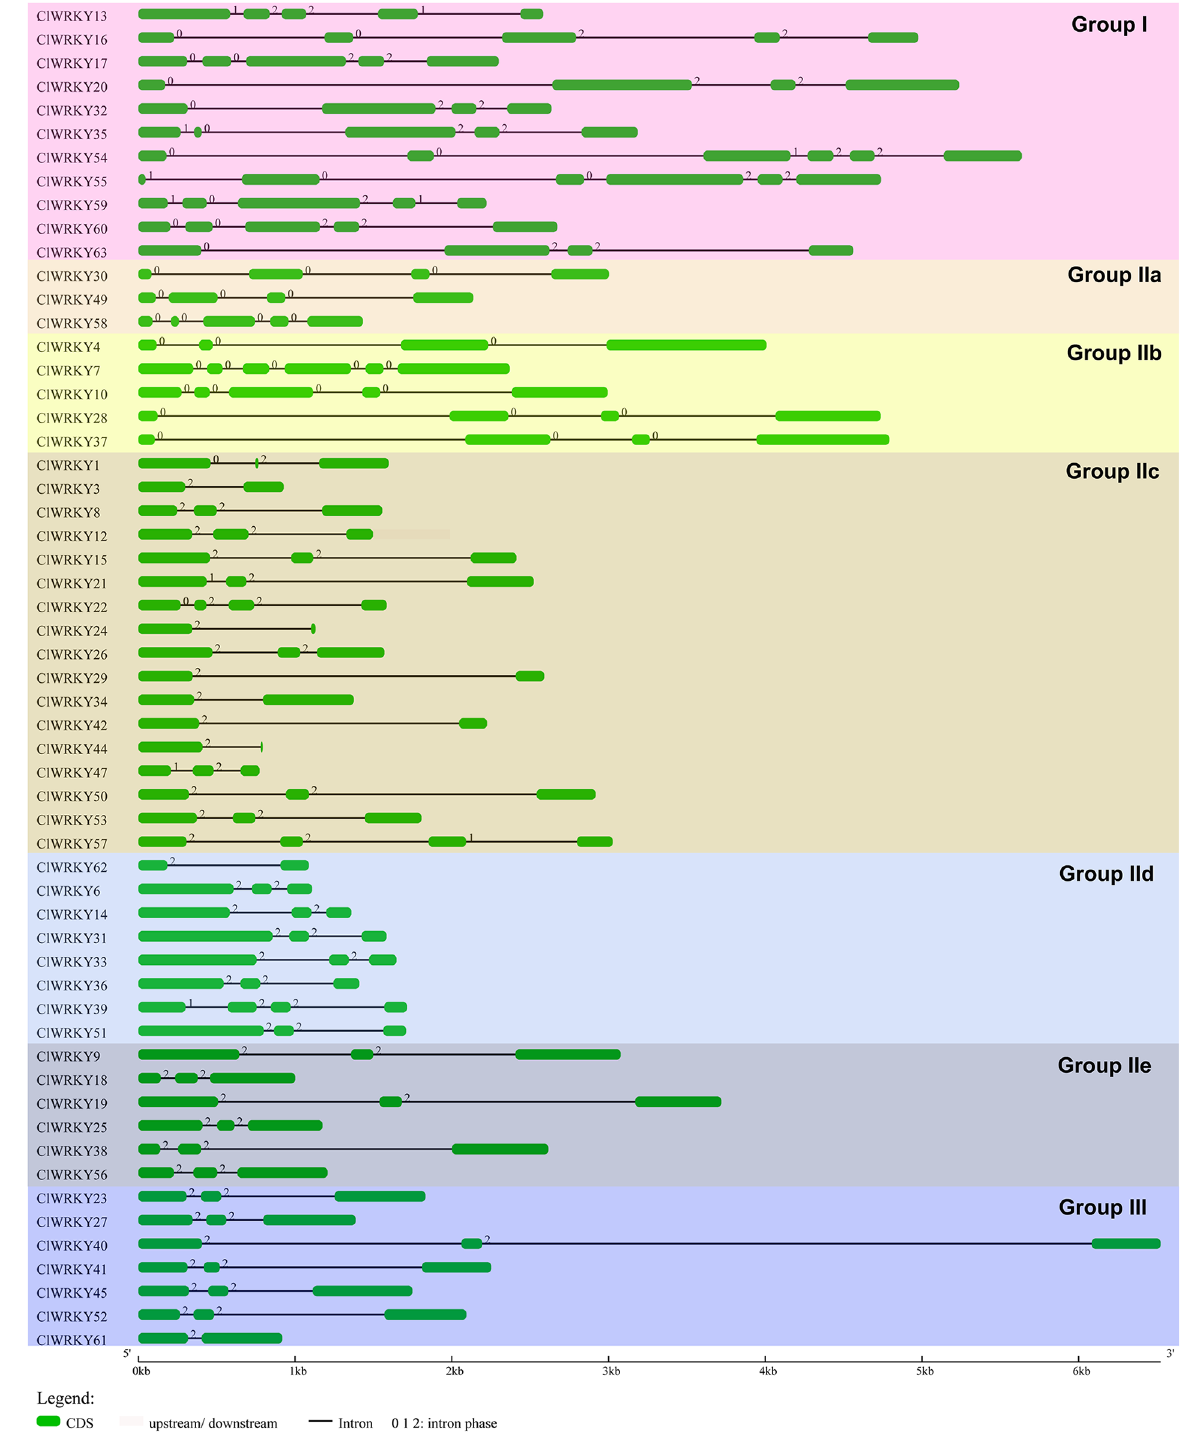
Fig 3. Illustration of the gene structure of 57 ClWRKY transcription factors. Genes were separated into their respective groups with different colors. Exons were shown using green round-corner rectangle while introns were shown using black solid lines (5 0 -3 0 ).